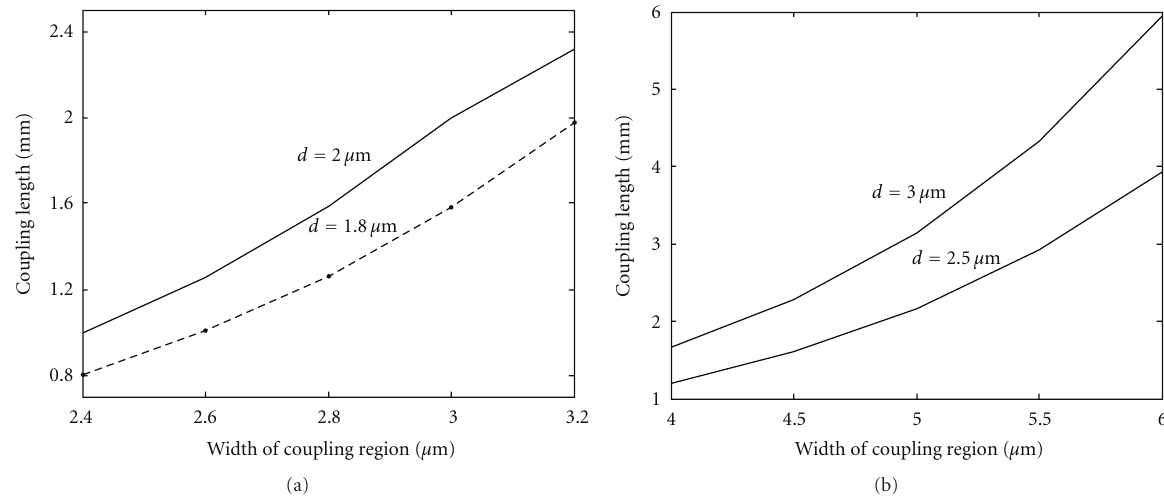
Figure 6: (a) Variation of coupling length with core separation: nonlinear coupling region. (b) Variation of coupling length with core separation: nonlinear core